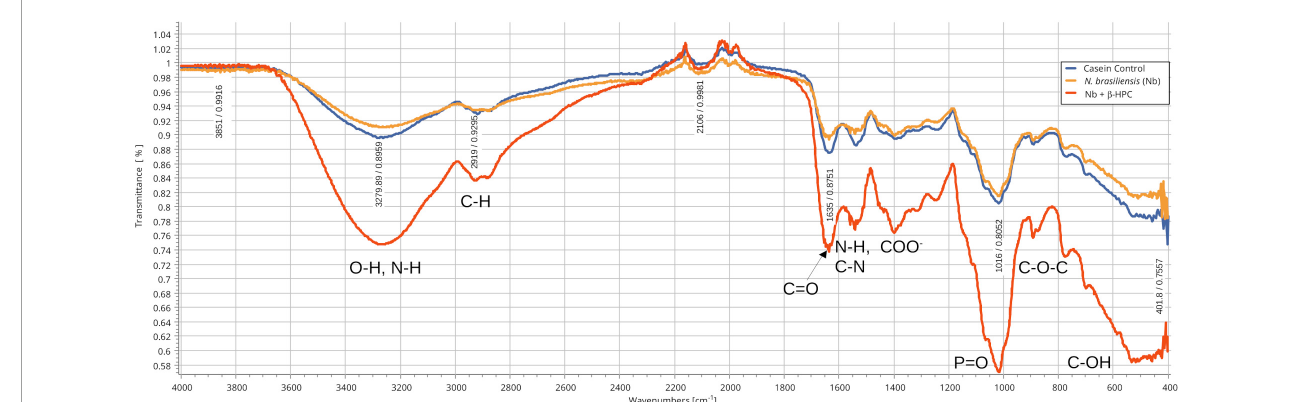
FIGURE2 Comparison of FT-IR spectra of the hydrolytic activity of N. brasiliensis on casein with and without β -HFC. Culture medium alone, control (blue line), culture medium with 7 days of growth of N. brasiliensis (orange line), and culture medium with 7 days of N. brasiliensis + β -HPC (red line); the increase in the signals of the alcohol functional group (O–H), alkanes (C–H), amides I, II, and III ( C = O, N-H, C-N), the carboxylic acid (COO–), phosphate ( P = O), and ethers (C–O–C) characteristic of amino acids, when N. brasiliensis was incubated in the presence of β -HPC indicating greater hydrolysis of casein.